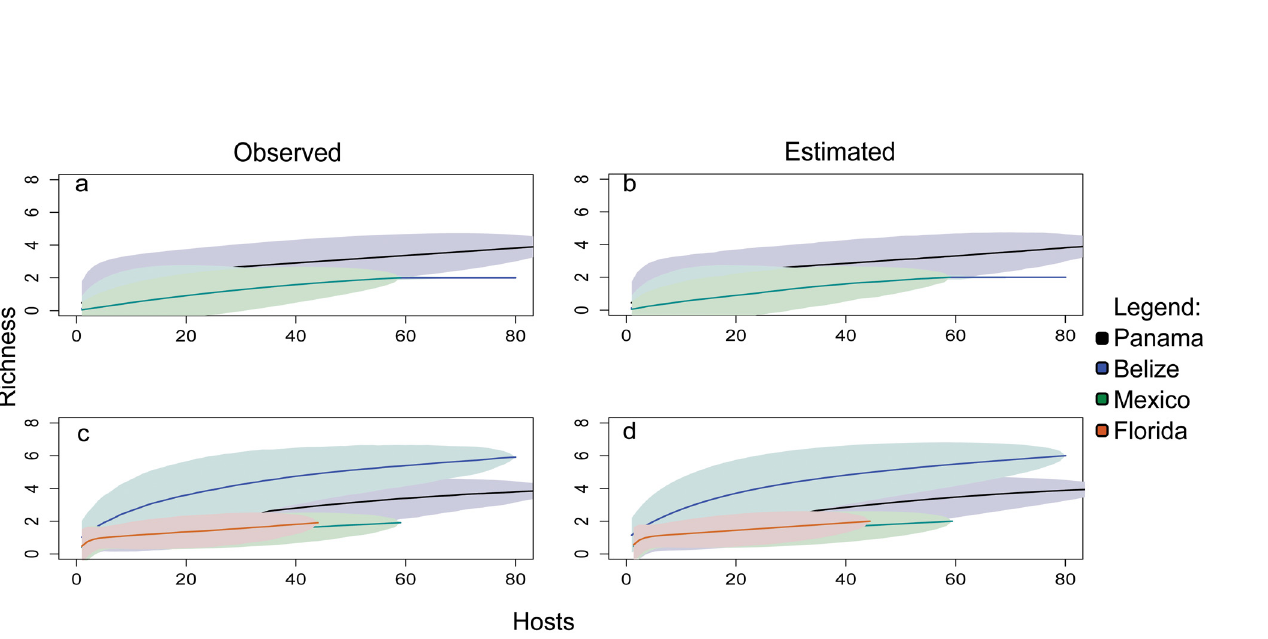
PLOS ONE | DOI:10.1371/journal.pone.0131075 June 22,